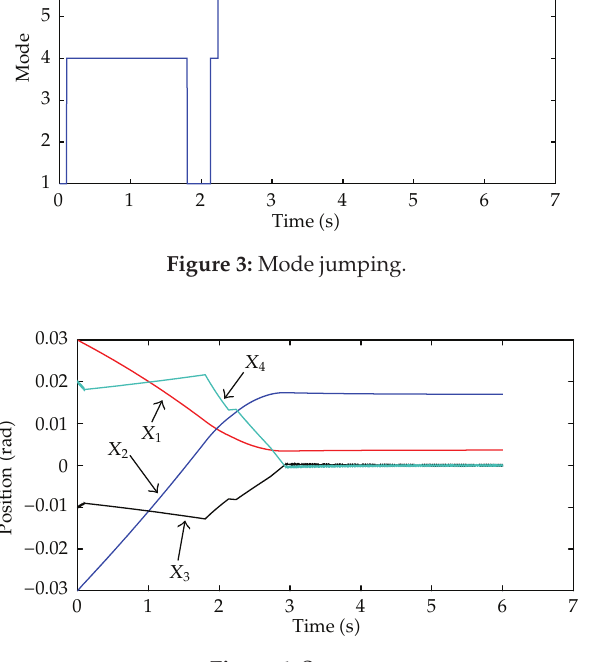
Figure 4: States.